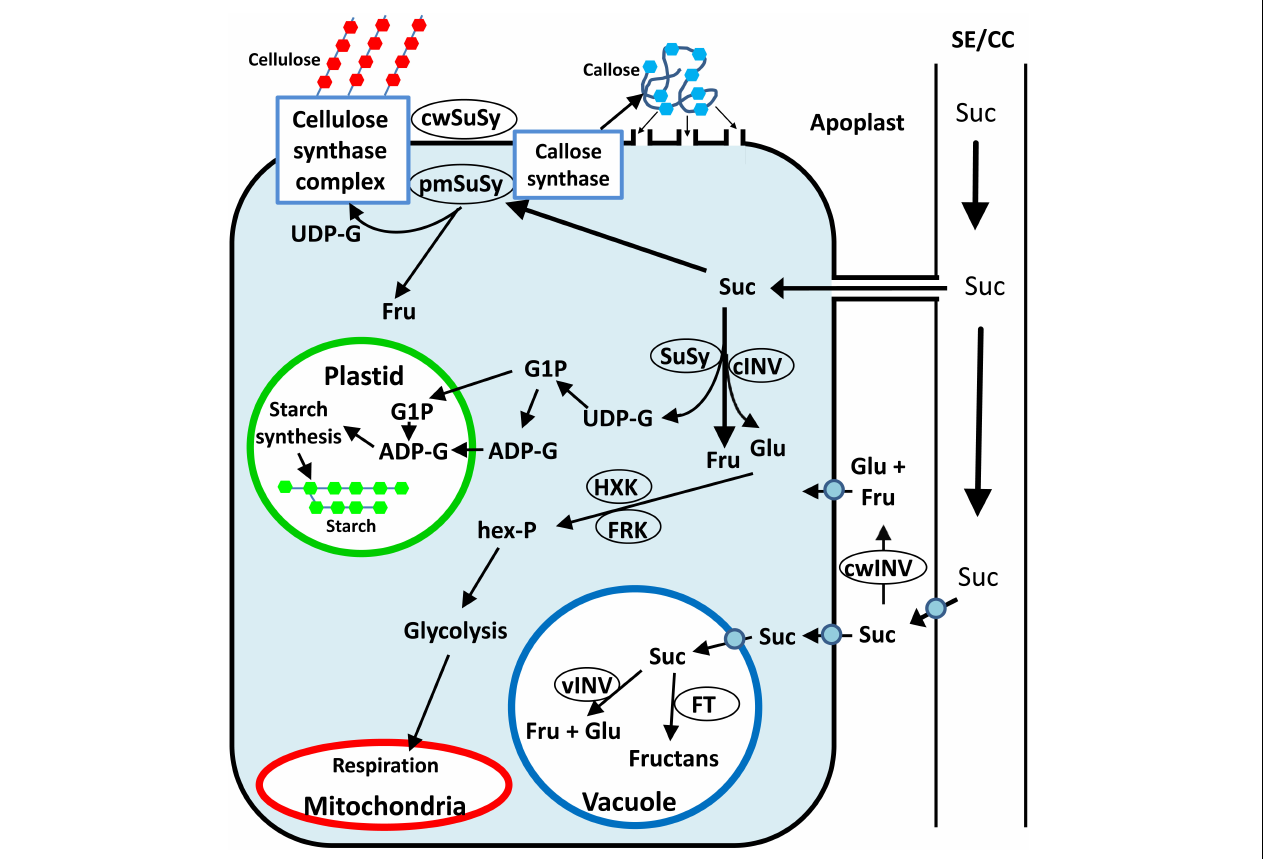
FIGURE 1 | Simplified schematic presentation of sugar metabolism in sink tissue cells toward cellulose, callose and starch synthesis. Suc can be hydrolyzed in the apoplast by cwINV to yield Glc and Fru, which can be brought into the cell by a monosaccharide transporter. Alternatively, Suc can be brought into the sink cell by a Suc transporter or enter through plasmodesmata. Inside the cell, Suc can be stored in the vacuole or hydrolyzed by vINV. In the cytosol, Suc can be hydrolyzed by cytosolic INV to yield Glc and Fru, or cleaved by cytosolic SuSy to yield Fru and UDP-G. The hexoses can be phosphorylated to hexose phosphates (hex-P), directed to starch synthesis in the plastid or to glycolysis and then respiration in the mitochondria or directed to other metabolic pathways. Plasma membrane associated SuSy (pmSuSy) and cwSUS can generate UDP-G that is used in the synthesis of cellulose for cell walls and callose for plugging